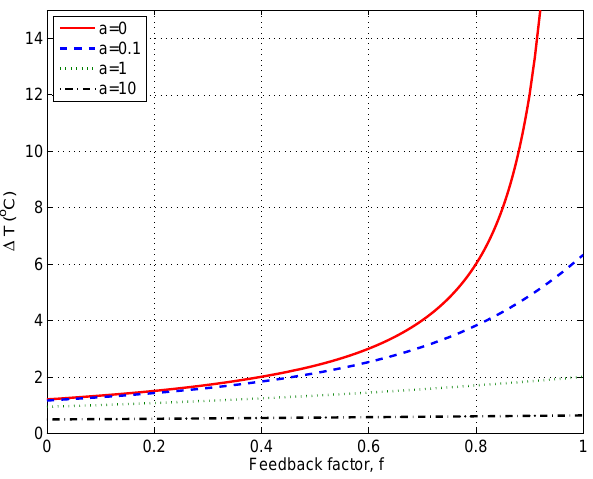
Fig. 2. Temperature response Δ 𝑇 as a function of feedback factor 𝑓 in a nonlinear, quadratic climate model, governed by Eq. (9). The curves correspond (from top to bottom) to increasing values of the magnitude 𝑎 = 𝑅 ′′ / 2 of the quadratic term; the values of 𝑎 for each curve are given in the figure’s legend, in the upper-left corner. The uppermost curve (red) corresponds to 𝑎 = 0 and is the same as the one shown in Fig. 1 above. Extreme sensitivity, expressed in the divergence of Δ 𝑇 , is only seen in the linear model; it rapidly van- ishes in the nonlinear model, as the nonlinearity factor 𝑎 increases.